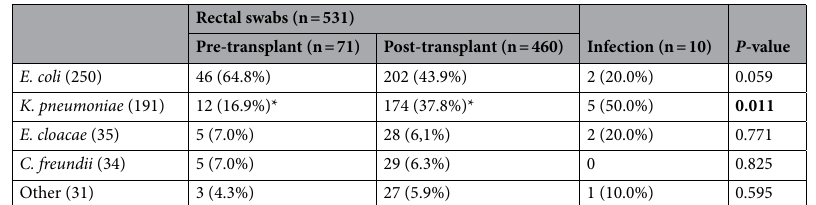
Table 1. Distribution of 541 multidrug-resistant Enterobacterales recovered from rectal swabs according to the pre and post-transplantation period and from clinical samples. *Statistically significant differences (bold type) were found between pre- and post-transplant rectal swabs. Other species included: 9 Morganella morganii , 7 Klebsiella oxytoca , 6 Proteus mirabilis , 5 Enterobacter aerogenes , 2 Citrobacter braakii , 1 Enterobacter asburiae and 1 Citrobacter